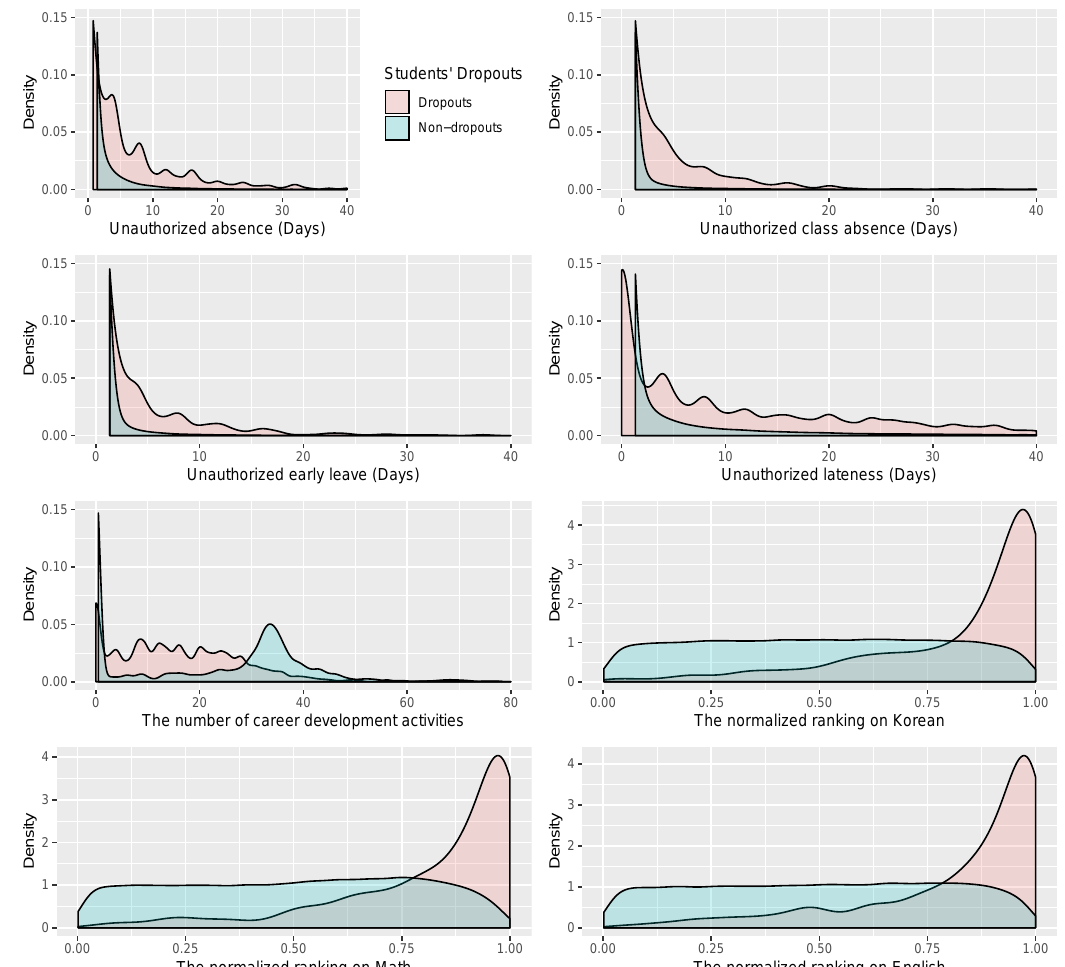
Figure 1. The density plots for the selected eight